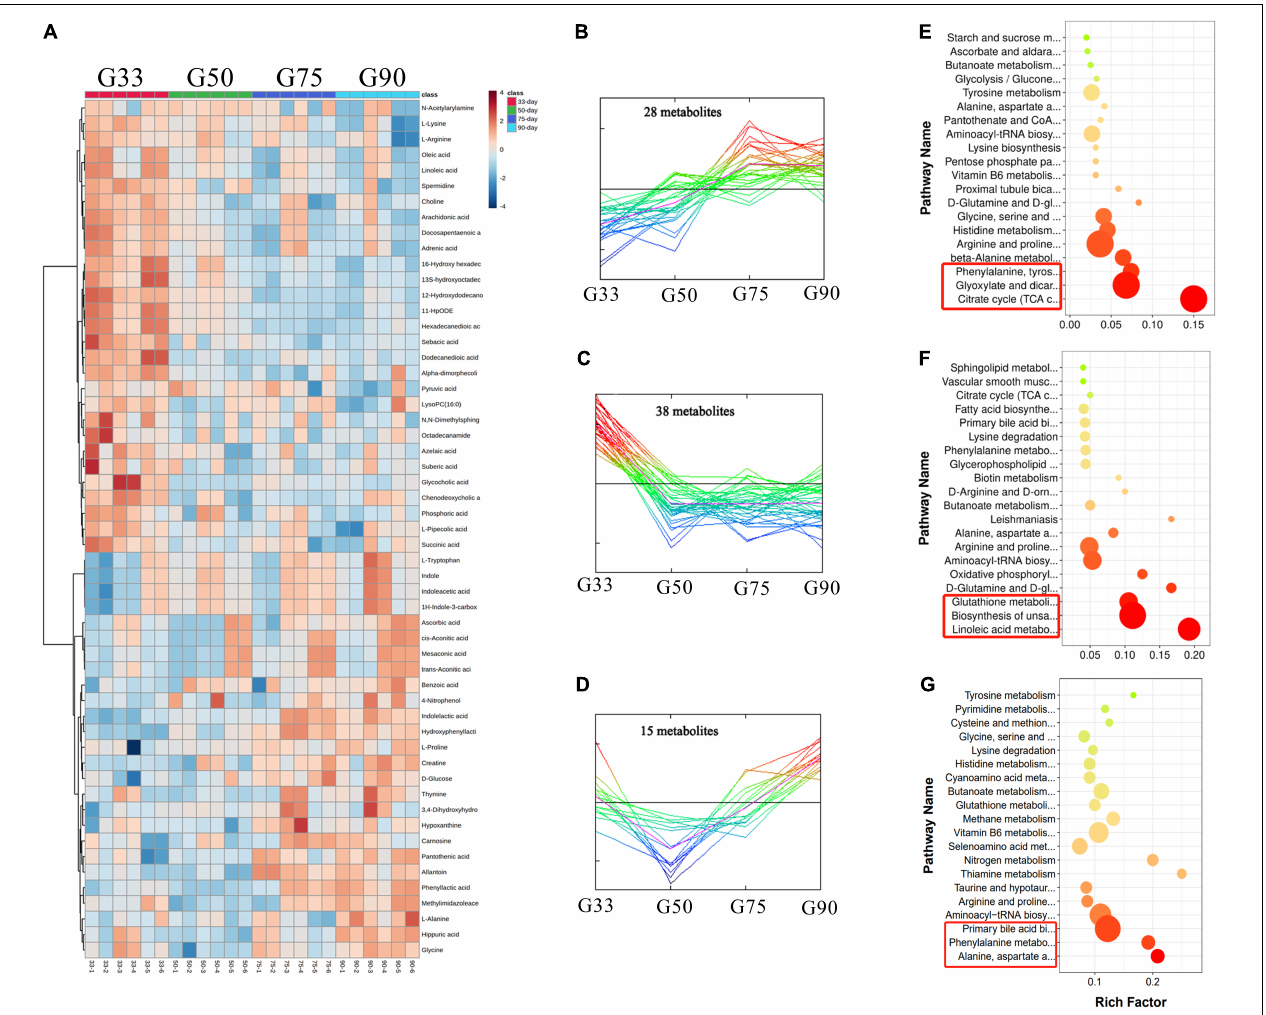
FIGURE 3 | Analysis of serum metabolome in Tibetan sows at different gestation periods. (A) Heatmap of the major differential metabolites in the serum of Tibetan sows at different gestation periods; (B–D) Cluster analysis of differential metabolites; (E–G) The enriched KEGG pathways for each